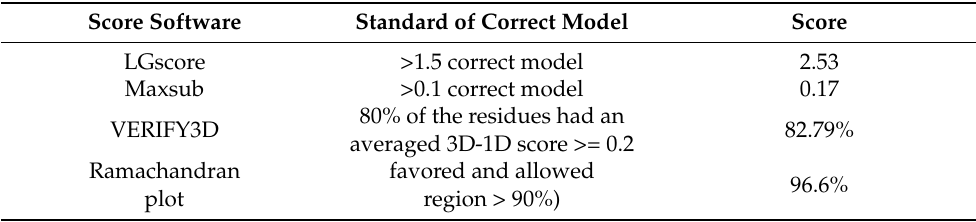
Table 1. LGscore, Maxsub, VERIFY3D, and Ramachandran plot score of the DHCR24